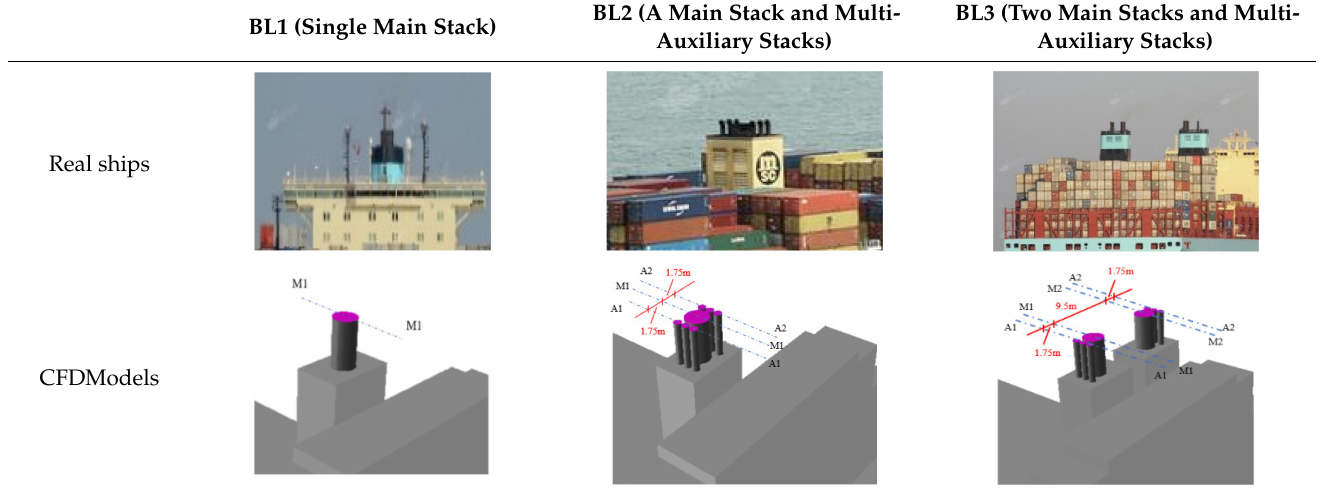
Table 2. Different stack configurations 1 and the corresponding physical